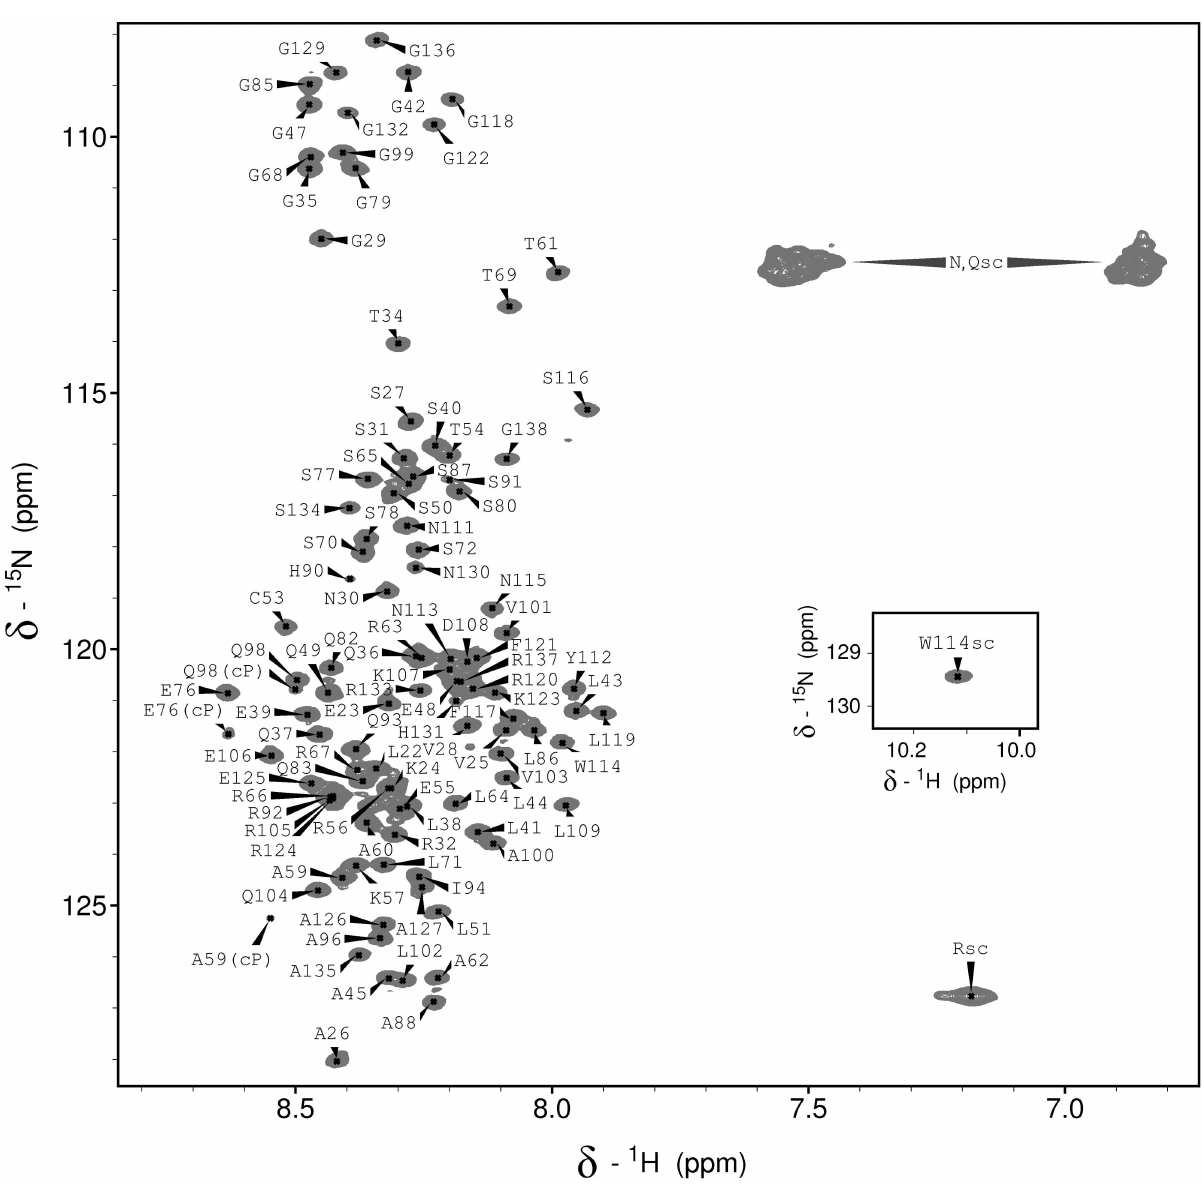
Fig 3. Residue-specific assignment of the 1 H- 15 N HSQC NMR spectrum of KISS1. The signal pairs from the unassigned asparagine and glutamineside chain amide groups are labeledas N,Qsc. The unassigned signal from arginineside chain HE-NE groupsis labeledas Rsc, and the inset shows the W114 indolesignal. Minor signals that likely arise from cis-Pro isomers are labeledwith